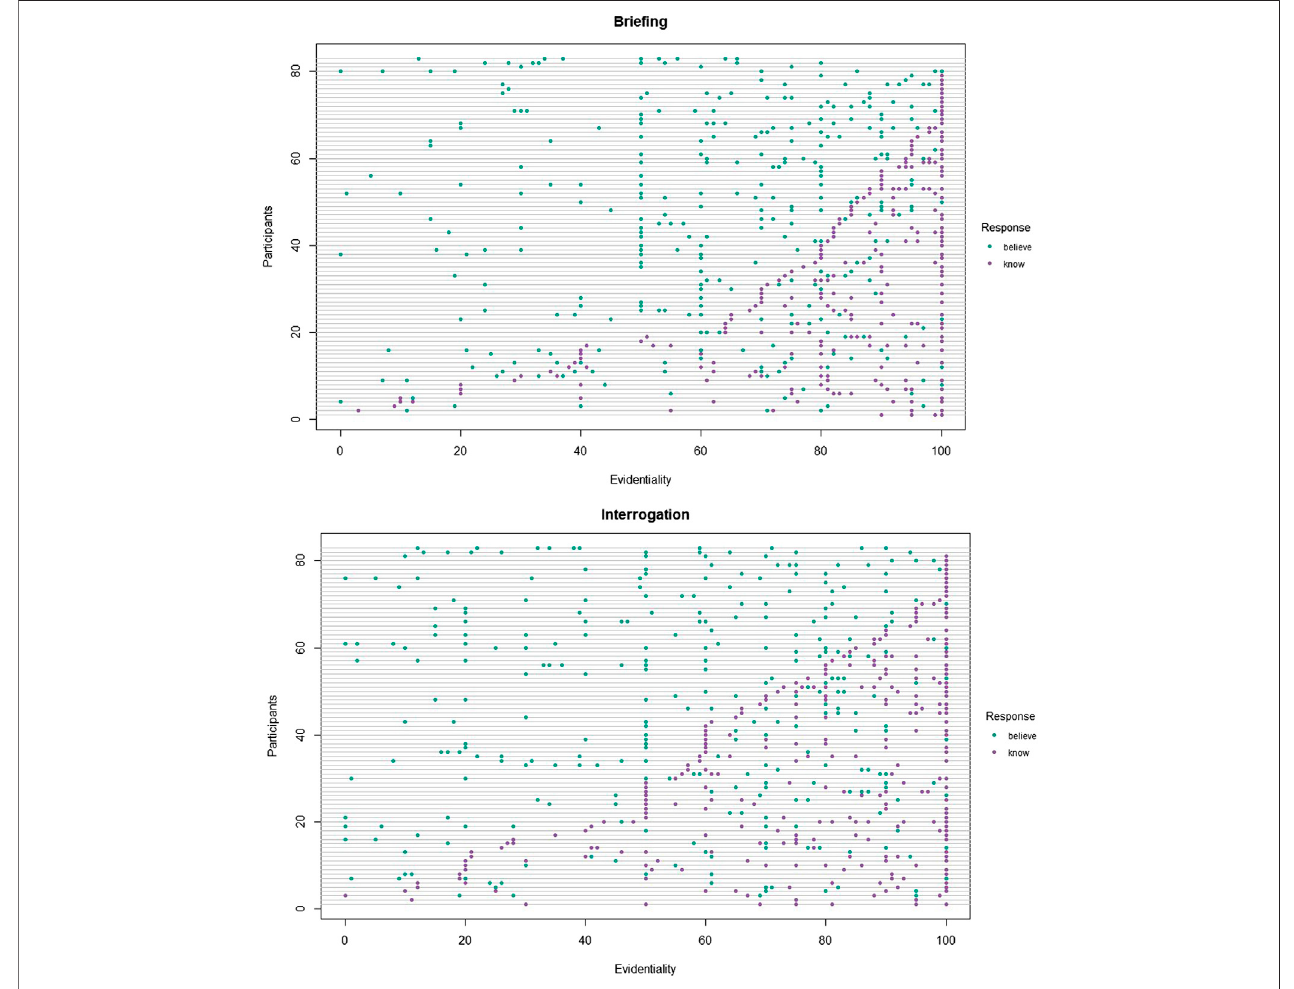
FIGURE 4 | The plots show the by-participant usage of ‘ know ’ (purple dots) and ‘ believe ’ (green dots) in the two different scenarios. The y -axis represents the individual participants, whereby each gray linebelongs to one participant. Participants are ordered from top to bottom according to the lowest degree of belief for which they used ‘ know ’ . The x -axis represent the evidentiality measure. This way we can see the degrees of belief of the participants when choosing a particular expression. A greendotthatappearsimmediately totheright ofapurple dotindicatesacasewhereaspeaker used ‘ believe ’ forstronger evidence thanforwhichthey elsewhere used ‘ know ’